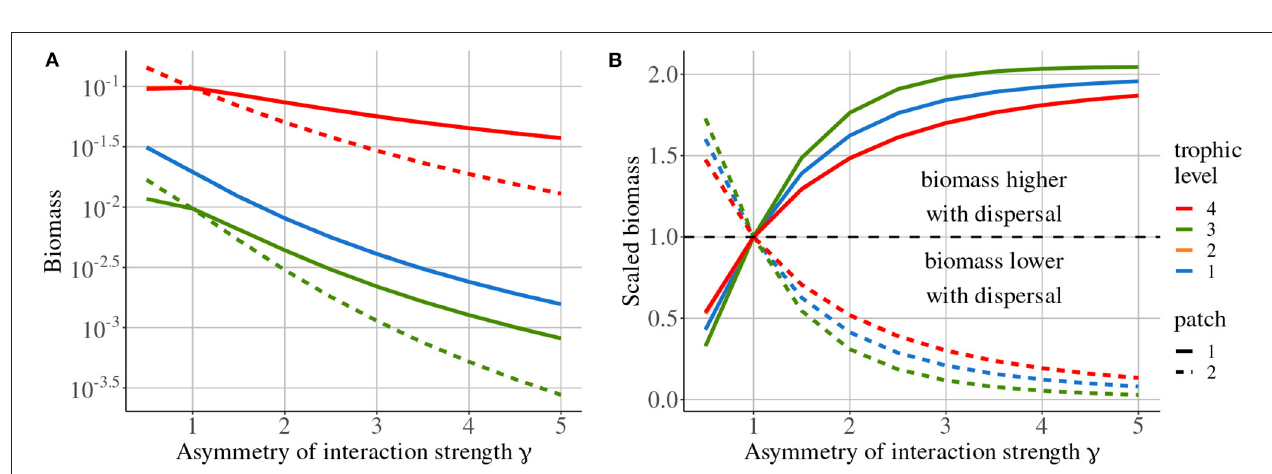
FIGURE 10 | Response of the metacommunity to stochastic perturbations depending on asymmetry of interaction strength γ and the perturbed species (top label). Line types represent the patch where species are perturbed. (A) Correlation between populations of top predators (species 4 in red) and carnivores (species 3 in green). (B) Coefficient of variation of biomass of top predators and carnivores in the patch where perturbations occur (i.e., if top predators are perturbed in patch #1, we only display the biomass CV of species in patch #1).